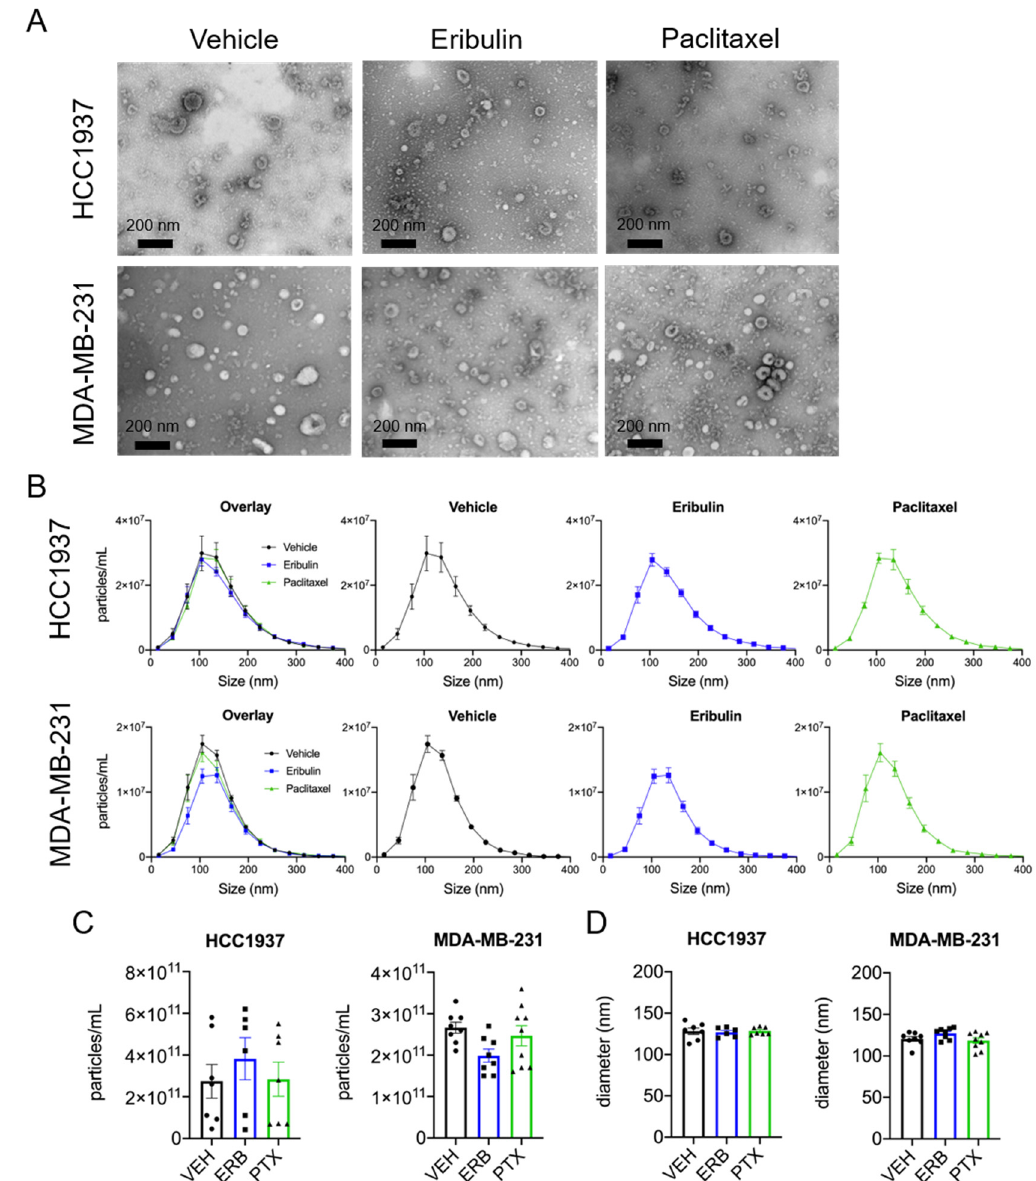
Figure 2 . Characterization of sEVs by electron microscopy and NTA. Cells were treated for 8 h with vehicle, 25 nM eribulin, or 50 nM paclitaxel and sEVs collected from the conditioned media. ( A ) sEVs were evaluated by transmitting electron microscopy. Scale bar = 200 nm. Pictures are representative of three experiments. ( B ) Size distribution of sEVs determined by ZetaView™, means ± SEM are shown, n = 6–9. ( C ) Mean particle concentration determined by ZetaView™. ( D ) Median particle diameter determined by ZetaView™. Points represent the results of independent experiments and bars represent the mean ± SEM, n = 6–9. Significance determined by one-way ANOVA with Tukey’s post-hoc test, and no treatments were significantly different from the other.